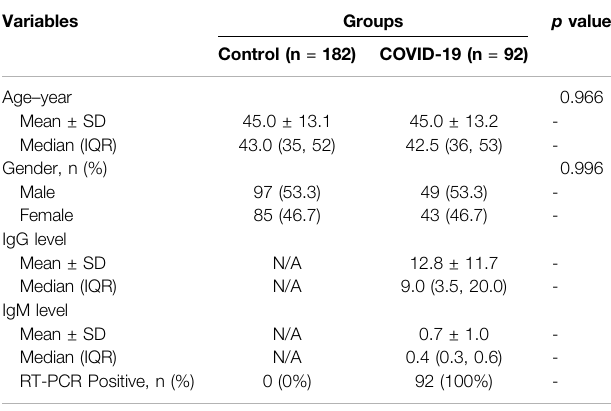
TABLE 1 | Characteristics of sub-groups of enrolled subjects. Variables Groups